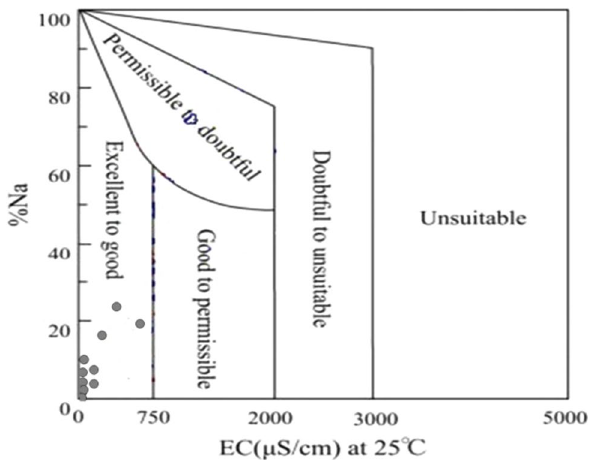
Fig. 5 Wilcox (1955), plot of the rating of Ajali River water samples on conductivity and Na percent basis